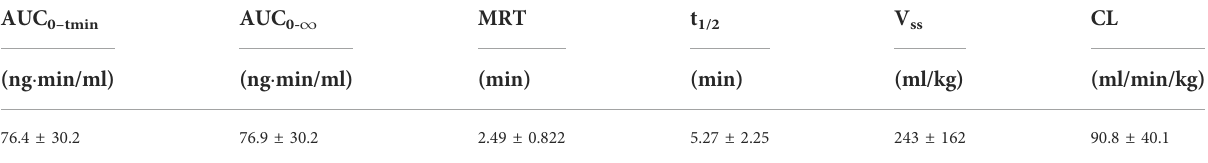
TABLE 4 Pharmacokinetic parameters of BPC157 in dogs following a single intravenous administration (mean ± SD, n = 6).